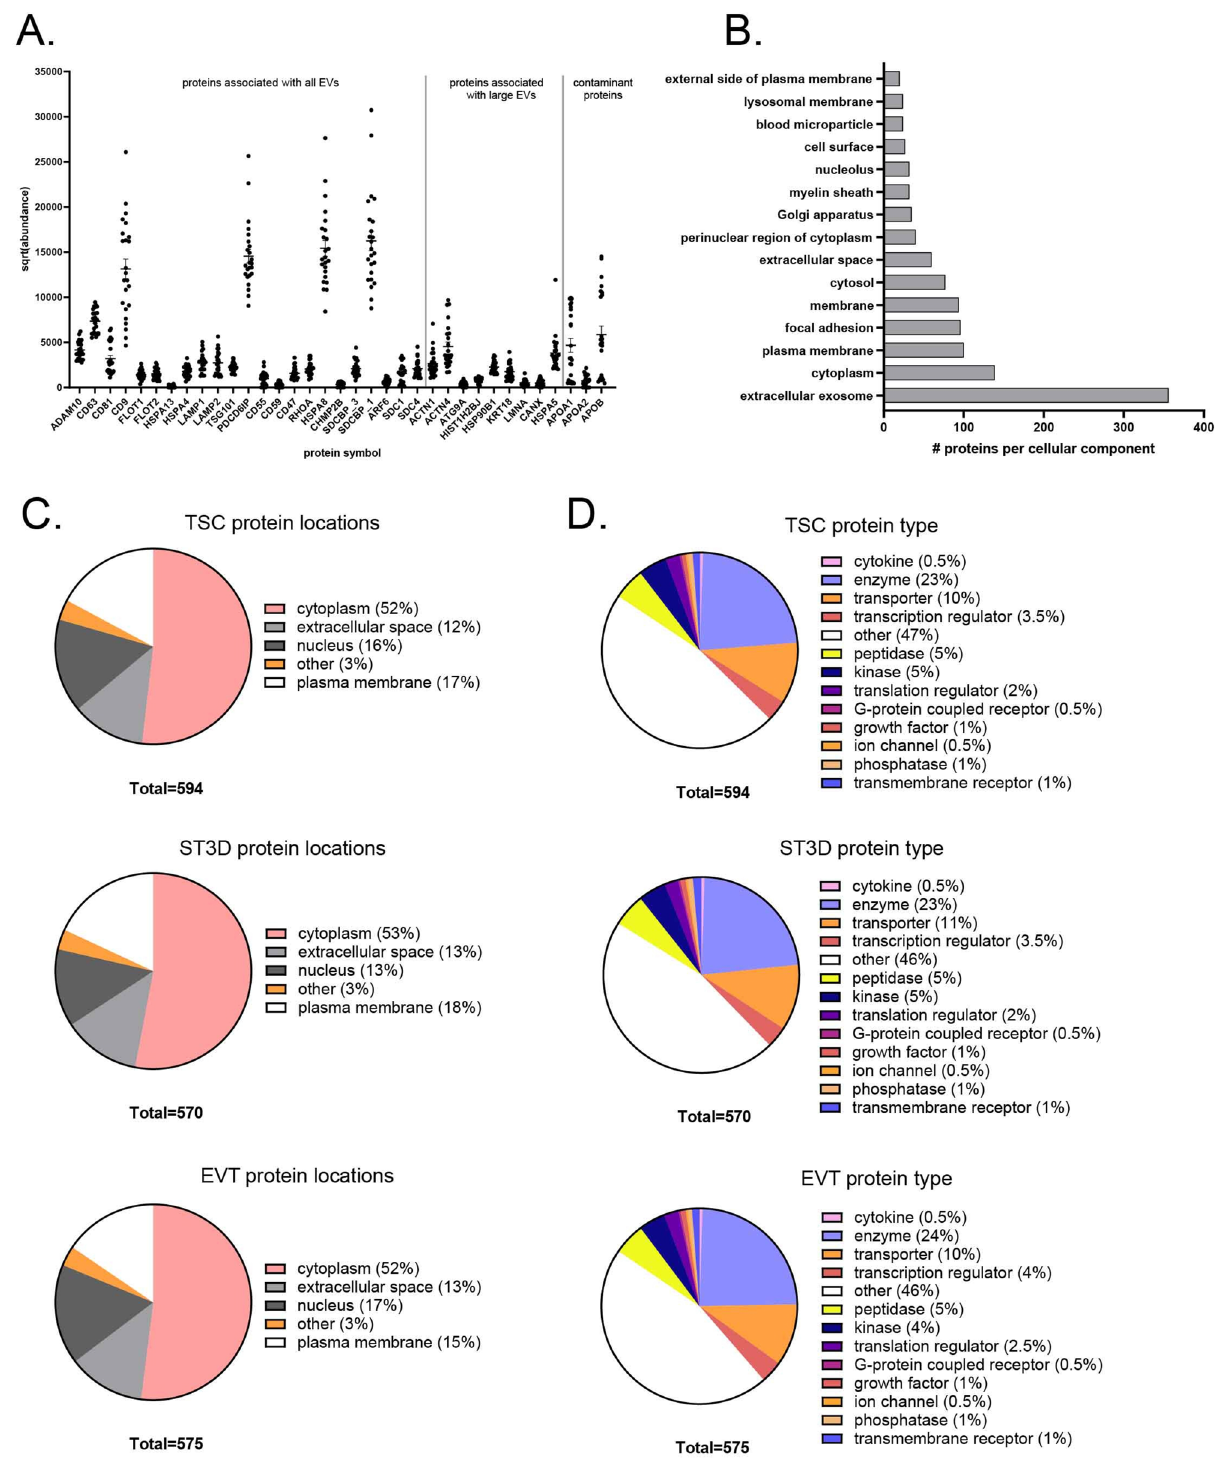
Figure 5. Characterization of protein cargo in trophoblast EV preparations. ( A ) The abundance of proteins associated with EVs, large EVs, and common contaminants is depicted. ( B ) DAVID pathways enrichment on the 763 proteins identified in all 24 EV samples; the top 15 components with an adjusted p-value of < 0.05 (Benjamini–Hochberg correction) are shown. ( C , D ) Protein location and type for all proteins detected in TSC, ST3D and EVT EVs as determined by